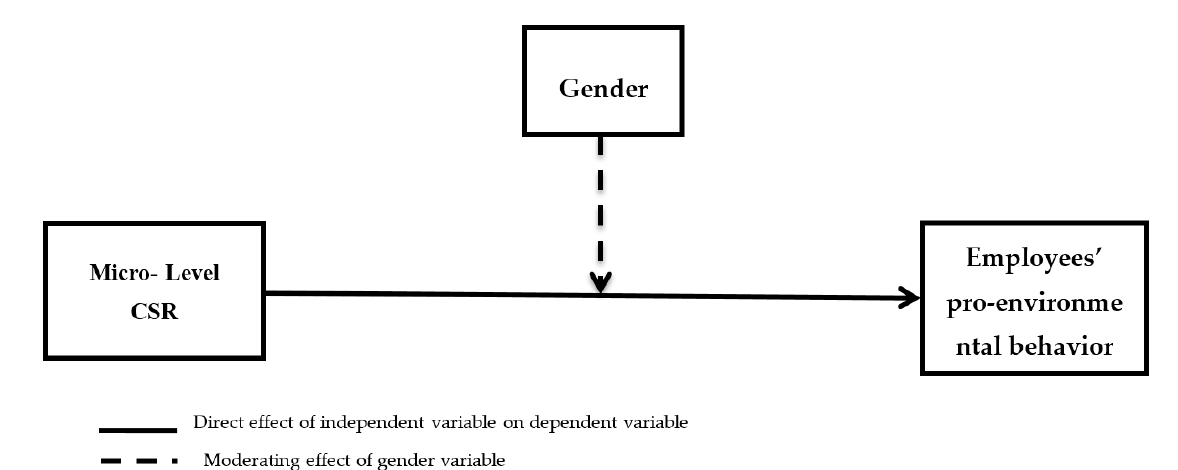
Figure 1. Proposed Research Model: This figure shows the path effects for H1 and H2. Where Micro-Level CSR (X) = the independent variable, Employee’s pro-environmental behavior (Y) = the dependent variable and Gender (M) = the moderating variable.